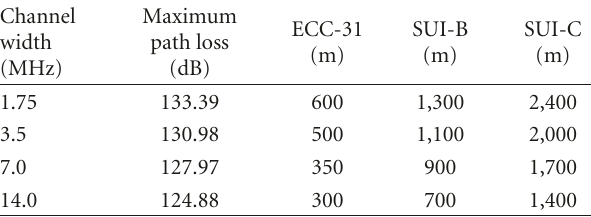
Table 10: Cell Range and Path Loss of Medium Access. Channel